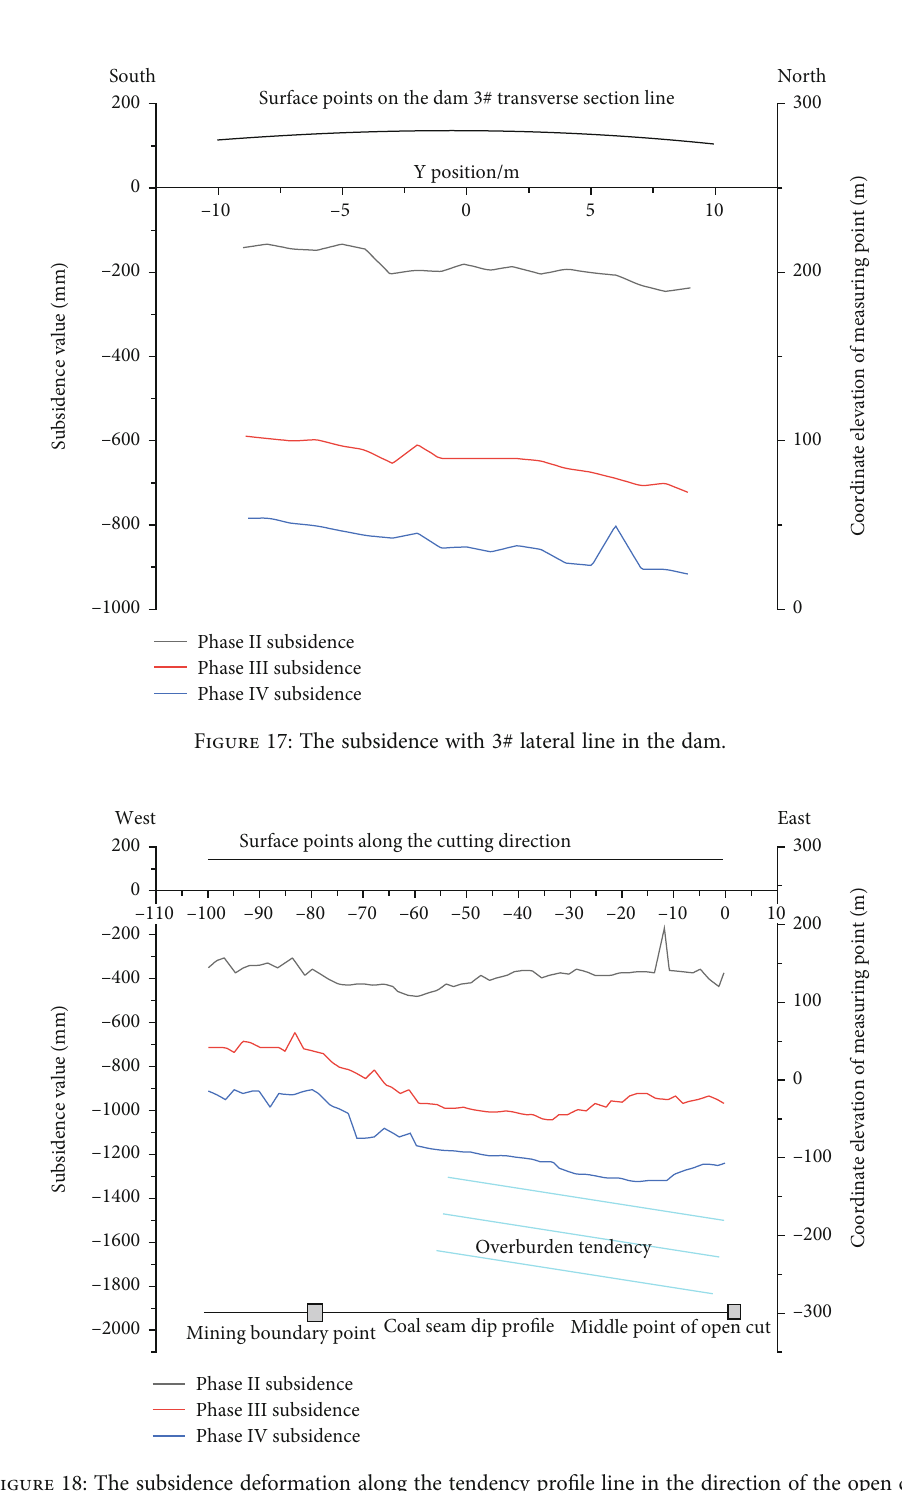
Figure 18: The subsidence deformation along the tendency pro fi le line in the direction of the open